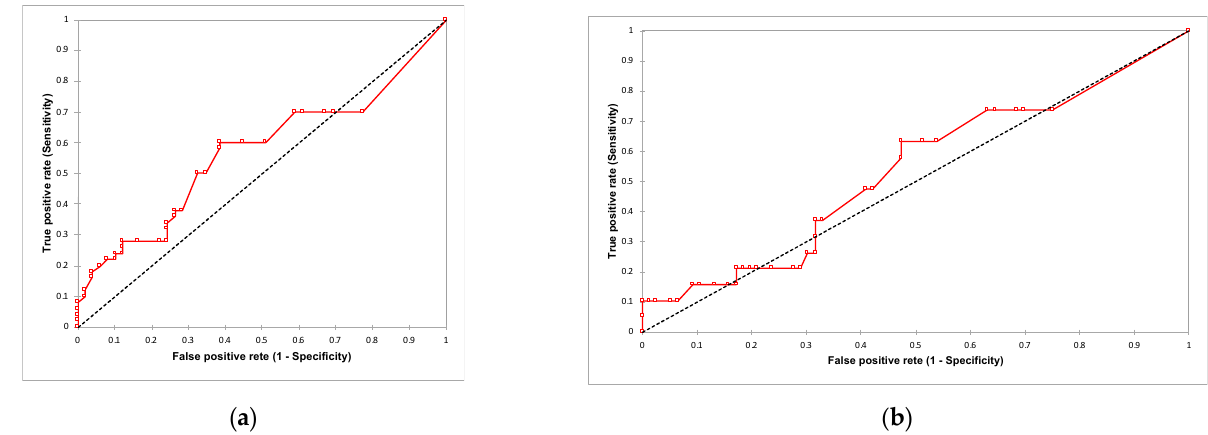
Figure A1. ROC curve analyses: ( a ) the AUC value is 0.57 for the DRFS ( p = 0.244); ( b ) and 0.54 for the OS ( p = 0.642); black dashed line: random chance; red line: ROC